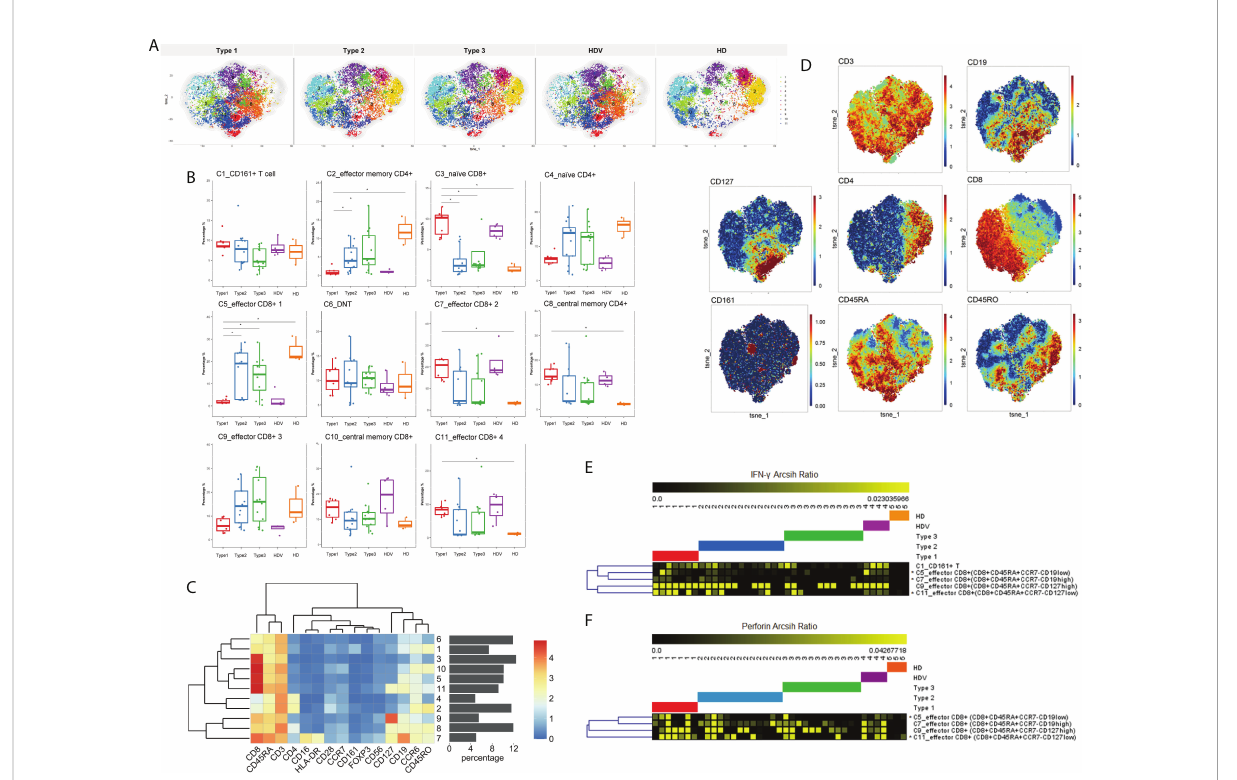
FIGURE 4 T-cell activation in subsets of LT recipients is associated with vaccination responder. (A) CyTOF-identi fi ed cell clusters from CD3+ cells visualized by t-SNE. (B) Percentage of each cluster among fi ve groups. Boxes represent interquartile ranges (IQRs). Each dot represents an individual groups: Type 1 (red), Type 2 (blue), Type 3 (green), HDV (purple), or HD (orange). (C) Heatmap showing expression patterns of various markers, strati fi ed by FlowSOM clusters. Heat scale calculated as column z-score of mean fl uorescence intensity (MFI). (D) viSNE projections of expression of the indicated proteins. IFN- g (E) and perforin (F) expression levels measured and compared in four kinds of effector CD8+ cells among fi ve groups. Signi fi cance was determined using Kruskal – Wallis test, followed by multiple pairwise comparisons. Statistical signi fi cance was set at a two-sided p -value <0.05 and adjusted p < 0.05. * p < 0.05. Percentages represent proportion of each identi fi ed cluster of all analyzed cells. LT, liver transplant; t-SNE, t-distributed stochastic neighbor embedding; HDV, healthy donors vaccinated with the inactivated vaccine; HD, healthy donors without